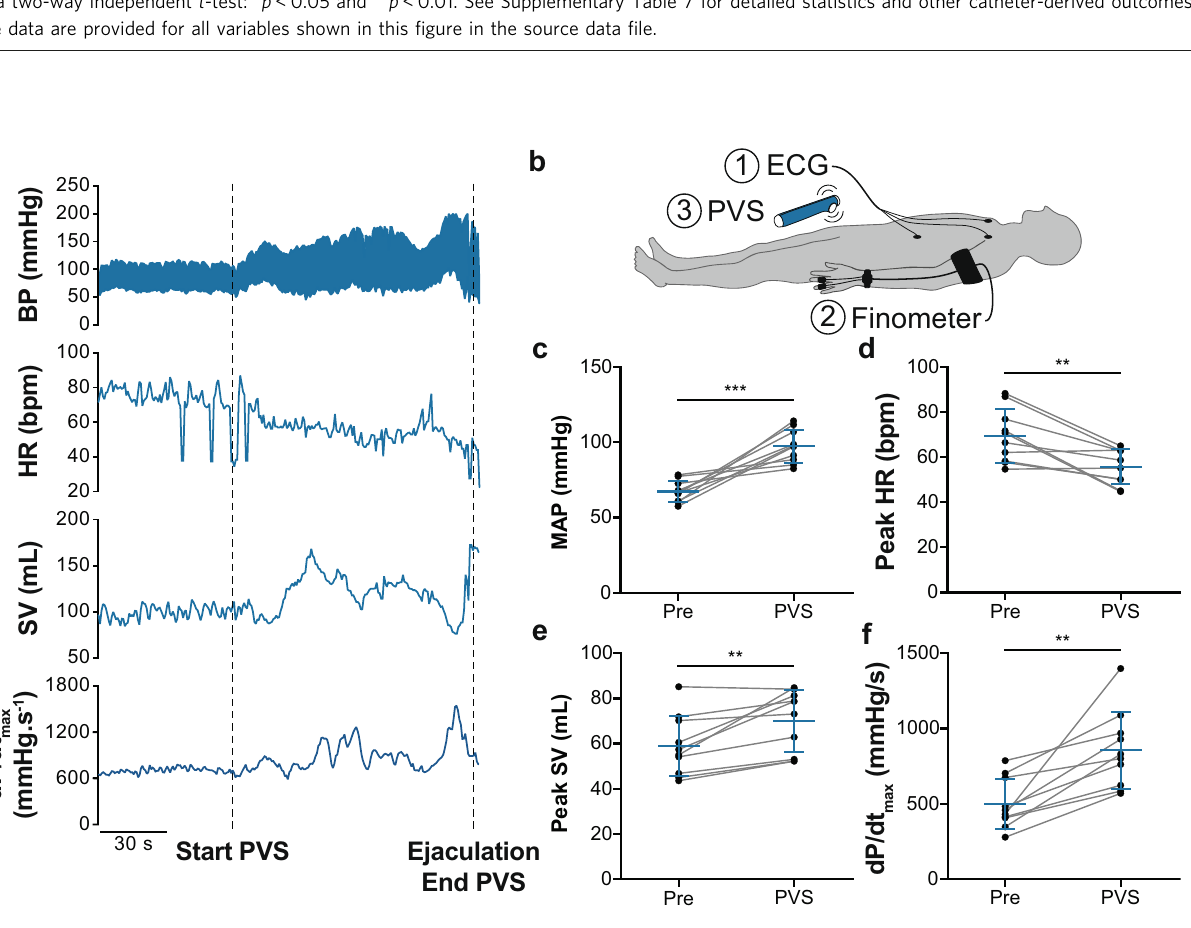
Fig. 9 Effects of penile vibrostimulation (PVS) on model- fl ow-derived cardiovascular outcomes in three individuals with chronic cervical SCI. a Representative data from one individual with a chronic cervical SCI undergoing PVS for sperm retrieval (complete C7 SCI; 41 years old; 13 years since SCI; AIS A). Note that upon the start of the stimulation with personal vibrator, there is a gradual increase in blood pressure (BP) and a reduction in heart rate (HR) that classically occurs in response to activation of the sympathetic nervous system during autonomic dysre fl exia. Note that both stroke volume (SV) and left ventricular (LV) contractility (dP/dt max ) also increased during PVS with values peaking at the time of maximal activation (ejaculation). b Cardiovascular measures were recorded via (1) electrocardiogram (ECG) and (2) fi nometry, while undergoing (3) PVS. c Mean arterial blood pressure (MAP), d peak HR, e peak SV, and f dP/dt max were obtained prior to and during PVS, demonstrating a consistent increase in cardiac function in response to activation of the sympathetic nervous system via PVS. Data are presented as mean ± SD with individuals represented as symbols ( n = 10) and were analyzed using paired t -tests: ** p < 0.01 and *** p < 0.001. See Supplementary Table 8 for detailed statistics and other fi nometry-derived outcomes. Source data are provided for all variables shown in this fi gure in the source data fi